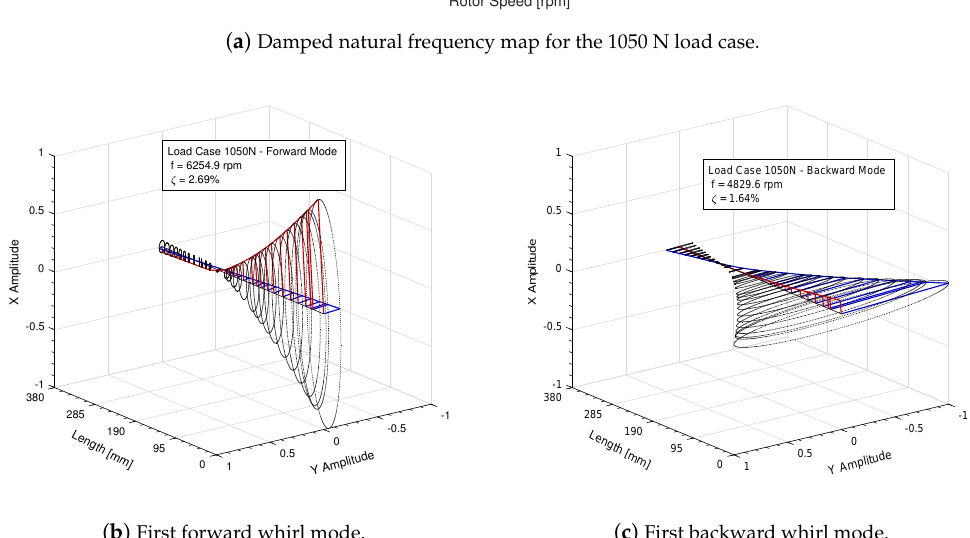
Figure 4. Results of the performed damped eigenvalue analysis for the 1050 N load